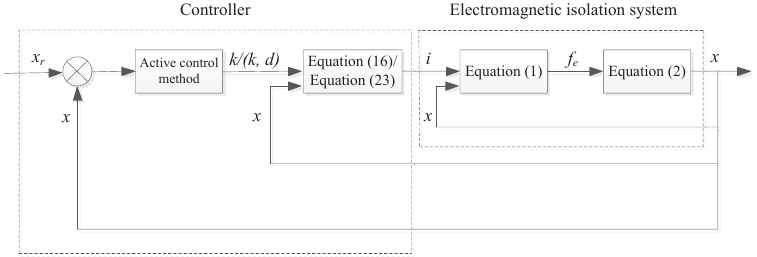
Figure 3. The control diagram with active control